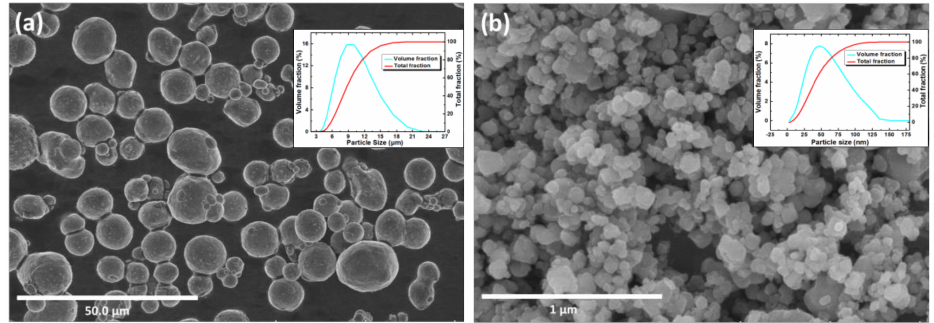
Figure 3. ( a ) As-received aluminium powder; ( b ) SiC nanoparticles.